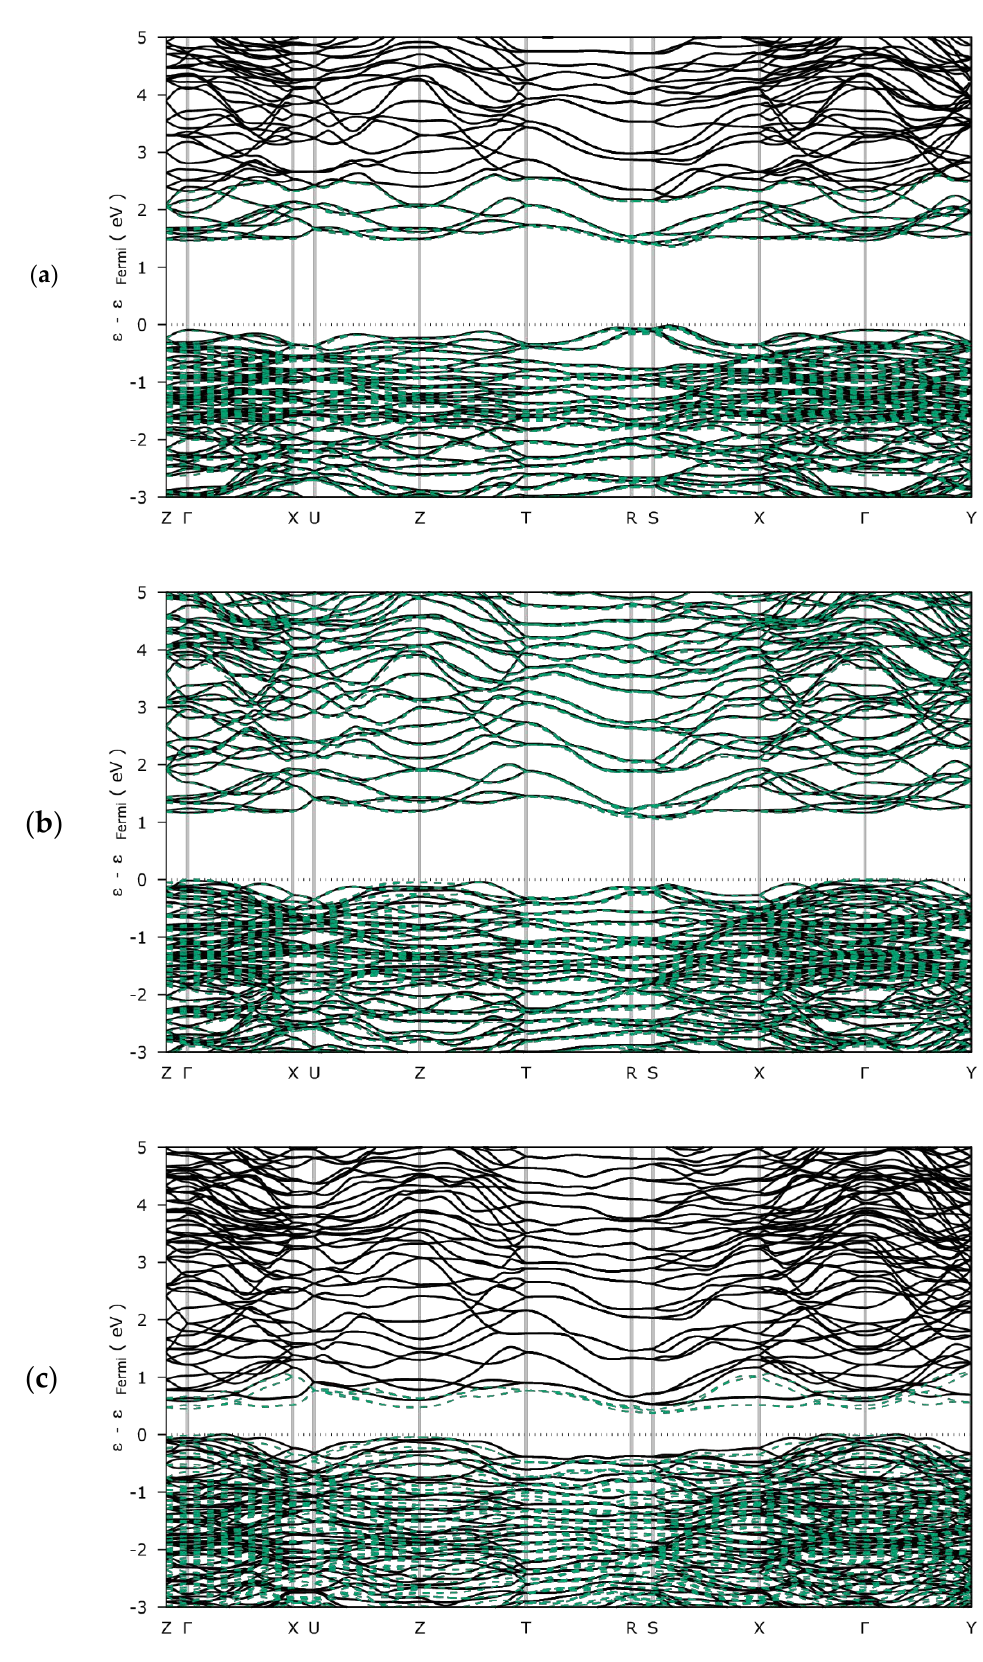
Figure 2. Relativistic (green) and non-relativistic (black) electronic band structures. ( a ) BaRh 2 Ge 4 S 6 ; ( b ) BaRh 2 Ge 4 Se 6 ; ( c ) BaRh 2 Ge 4 Te 6 .